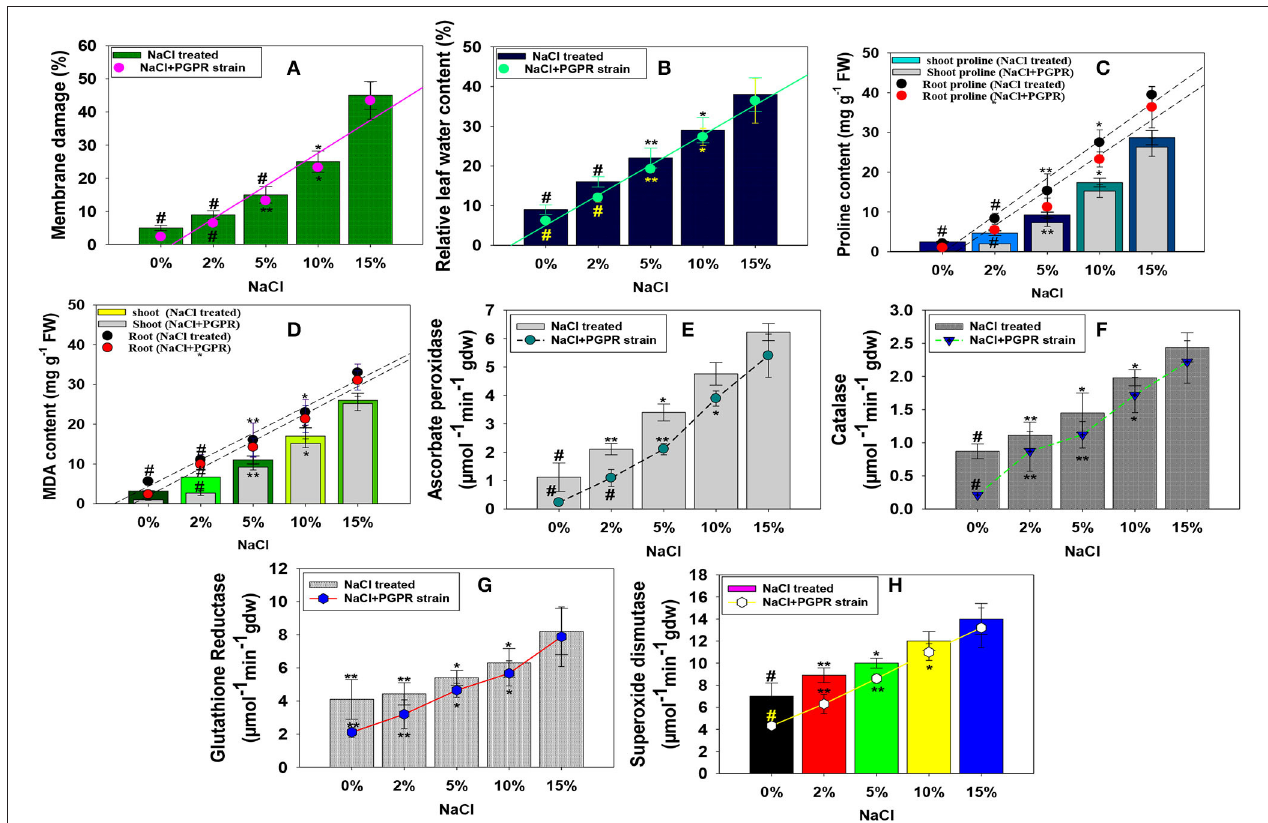
FIGURE 6 | Impact of different levels of NaCl on membrane damage (A) , relative leaf water content (B) , stressor molecules; proline (C) , MDA content (D) , and antioxidant enzymes; ascorbate peroxidase (E) , catalase (F) , glutathione reductase (G) , and superoxide dismutase (H) of radish plants raised in soils inoculated with halotolerant K. radicincitans . In this figure, bar and line diagrams represent the mean values of three replicates ( n = 3). Corresponding error bars represent standard deviation (SD) of three replicates (SD, n = 3). The asterisks *, **, and # denote statistical significance at p < 0.05, p < 0.005, and p < 0.001, respectively, computed by Student’s T